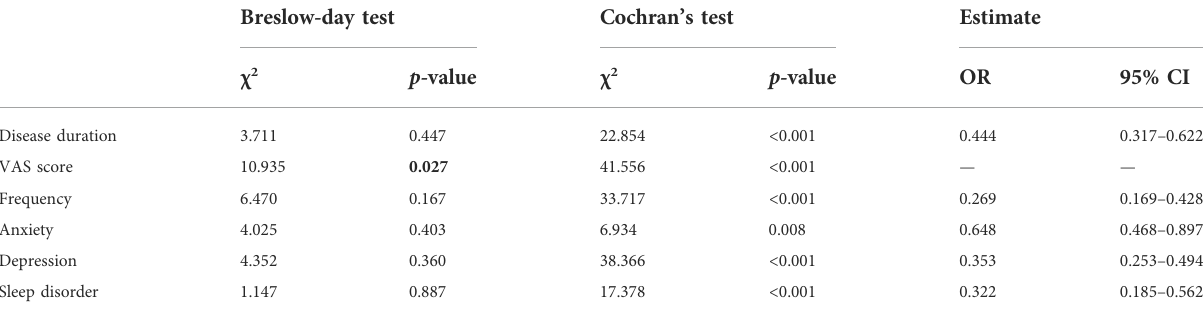
TABLE 4 Results of Cochran – Mantel – Haenszel